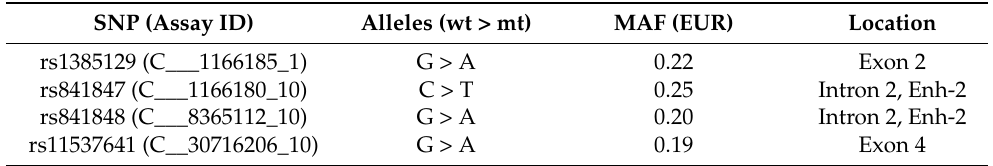
Table 1. Key data of the examined SNPs. G/C: wild-type allele (wt); A/T: mutant allele (mt); MAF: Minor Allele Frequency; Enh-2: enhancer